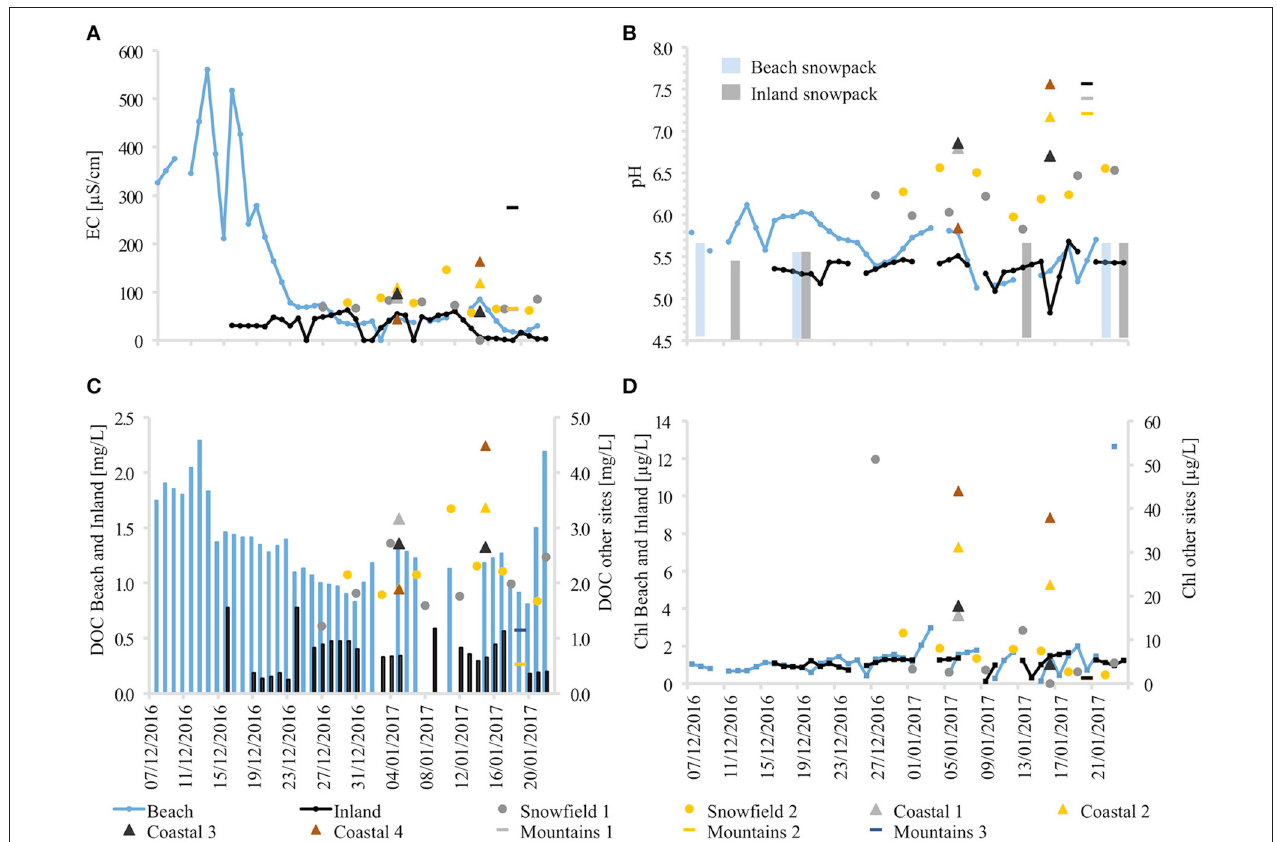
FIGURE 6 | Seasonal snowmelt dynamics and snowmelt chemical characteristics at all sampling sites. (A) Electrical conductivity, (B) pH, (C) DOC, and (D) Chlorophyll concentrations.